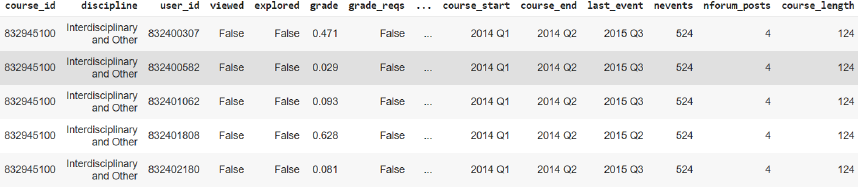
Fig. 1. Canvas dataset preview after pre-processing and missing values